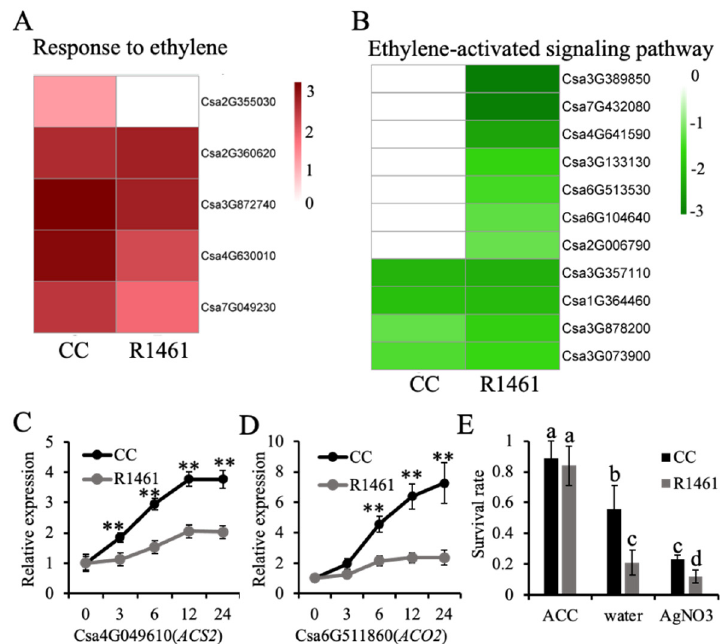
Figure 3. Ethylene confers chilling tolerance in cucumber. ( A , B ) Heat maps of the expression levels of genes belonging to “response to ethylene” ( A ) and “ethylene-activated signaling pathway” ( B ). Chilling-induced expression changes are shown, expressed as log 2 FC based on RNA-seq data. ( C , D ) Relative expression levels of ACS2 ( C ) and ACO2 ( D ) in 16 days old seedlings of CC and R1461 under chilling stress. Expression at 0 h was set to a value of 1. Data are the means ± SD of three biological replicates consisting of 3–6 individual seedlings each. ** means p < 0.01, Student’s t -test. ( E ) Survival rates of CC and R1461 under 4 days of chilling treatment and 7 days of recovery with 100 μ M ACC, water, and 100 μ M AgNO3 treatment. Data are the means ± SD of three biological replicates consisting of 30 seedlings each. Different letters above the bars indicate significant differences among samples, as determined by one ‐ way ANOVA/Duncan ( p < 0.05).